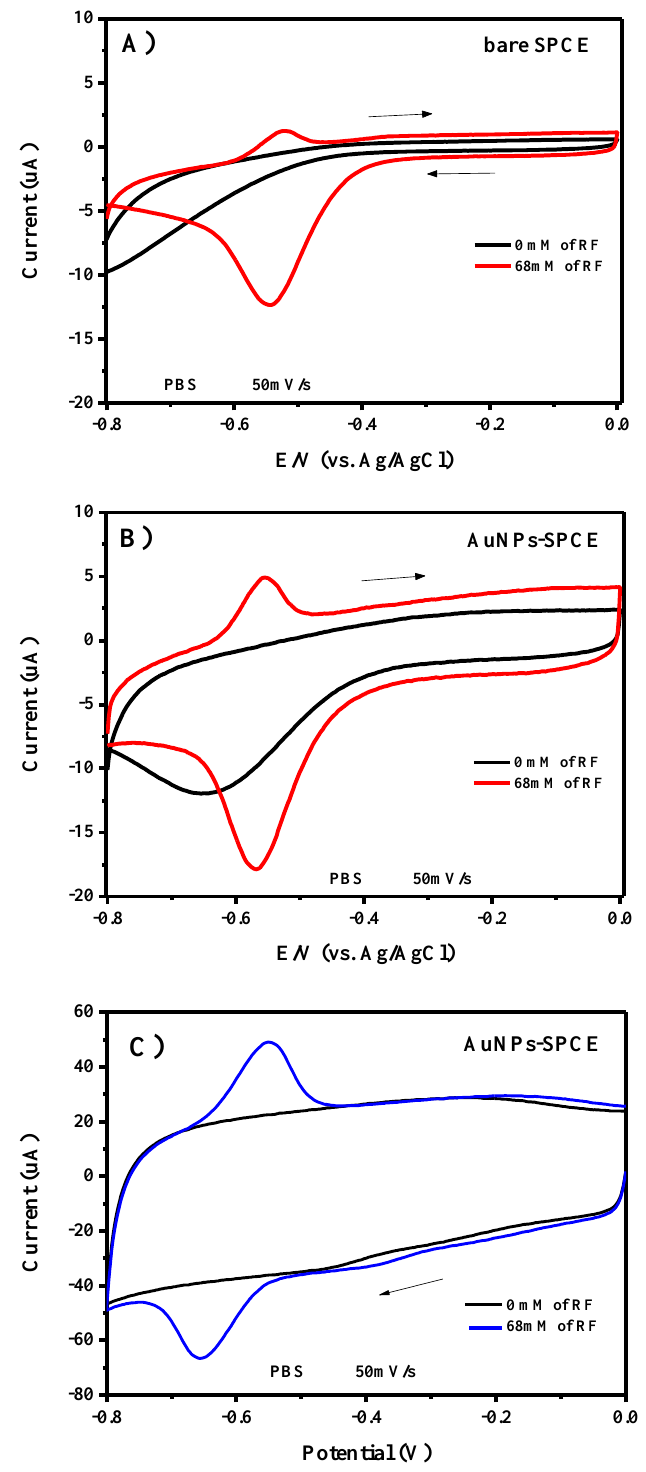
Figure 11. Electrochemical behavior of ( A ) bare SPCE and ( B , C ) AuNPs-modified electrode in the absence and presence of riboflavin. CV was performed in de-aerated 1 M PBS at a scan rate of 50 mV/s. The arrows indicate the direction of the starting potential scan.